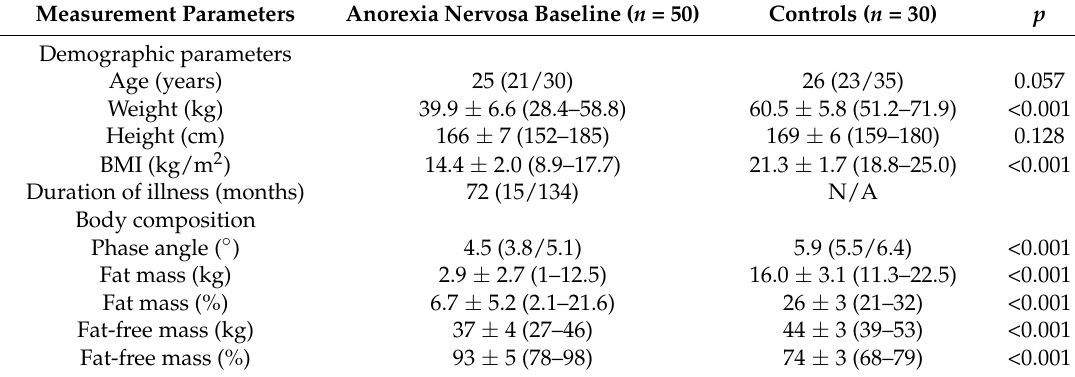
Table 1. Demographic characteristics and bioimpedance data in patients with anorexia nervosa on admission and in the healthy control group.